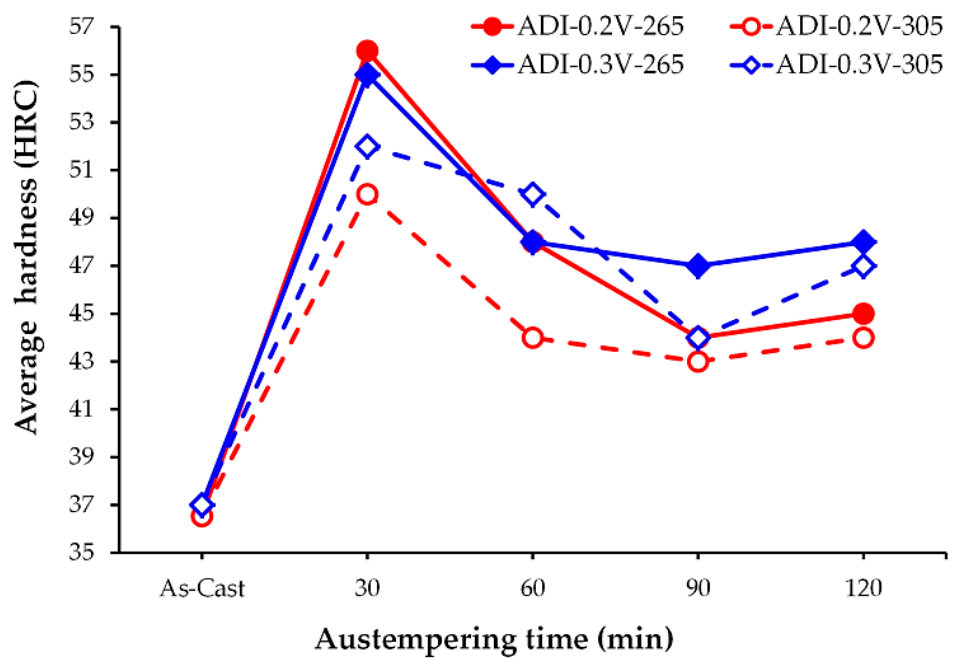
Figure 11. Austempering time influence on the Rockwell C hardness.